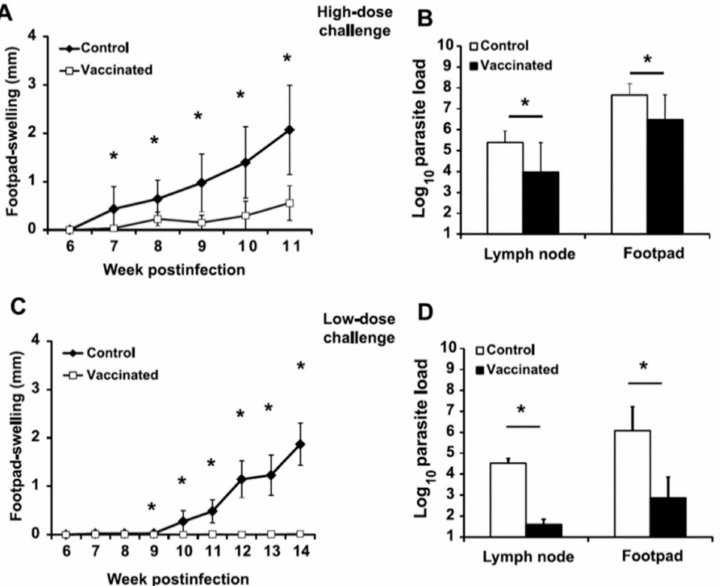
Figure 1. Course of Leishmania amazonensis infection in control and vaccinated mice. BALB/c mice were inoculated with PBS (control) or with 1 × 10 7 Li ∆ HSP70-II attenuated promastigotes suspended in PBS (vaccinated) in the right footpad. At week 12 after vaccination control and vaccinated mice were challenged with 5 × 10 6 (( A , B ); high dose, n = 8) or 5 × 10 4 (( C , D ); low dose, n = 5) stationary L. amazonensis promastigotes in the left footpad. In ( A ) and ( C ), swelling was calculated weekly and it is given as the difference in thickness between the challenged and the contralateral footpad (mean ± standard deviation (SD)). Parasite burden was individually determined by a limiting dilution assay in the left footpad and the left popliteal lymph node at week 11 ( B ) or 14 ( D ) after infectious challenge and it is represented as the mean + SD. * ( p < 0.05; Student (cid:48) s t-test). Results from one out of two similar experiments are represented. No parasites were detected in the liver or the spleen of mice from control or vaccinated groups in any of the